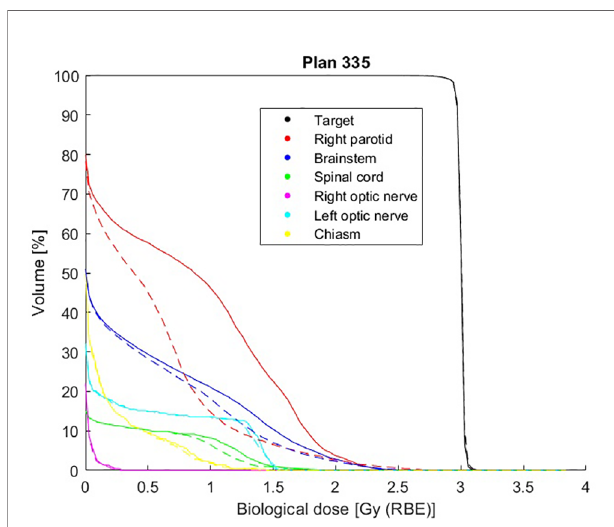
FIGURE 5 | Comparison of dose – volume histograms (DVHs) obtained with voxel-dose-based (solid line) and generalized equivalent uniform dose (gEUD)- based (dashed line) optimization for patient plan 335.